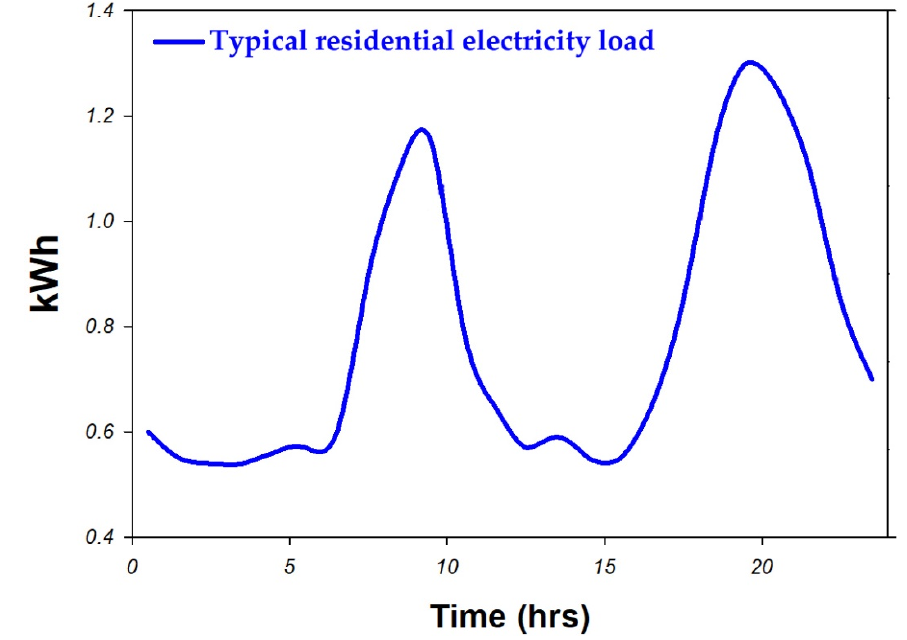
Figure 4. Typical residential house daily electricity load profile.